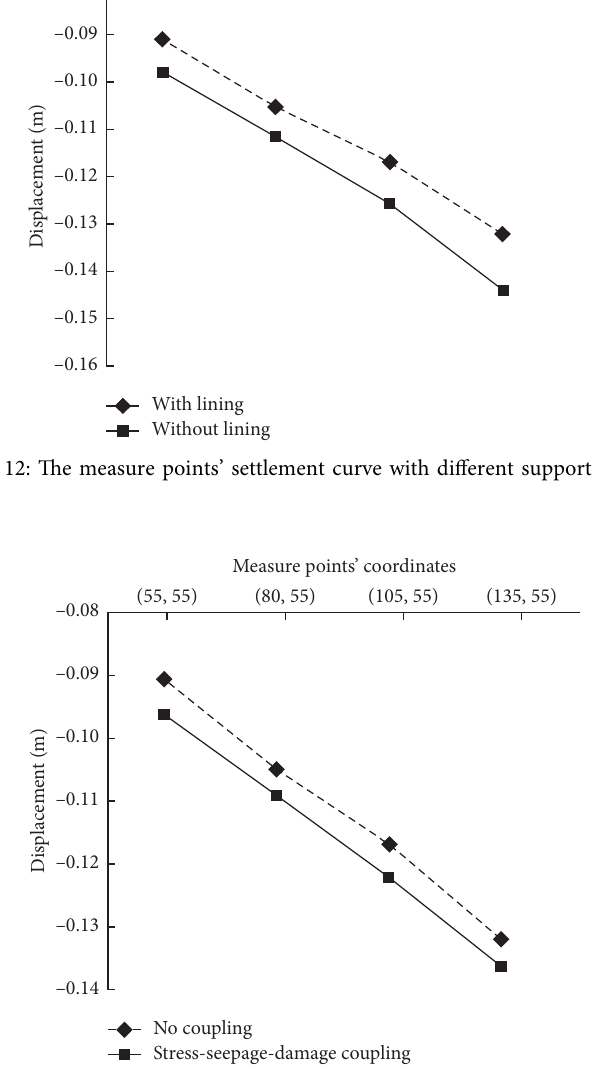
Figure 13: The measure points coordinates’ settlement curve for considering coupling and without coupling.